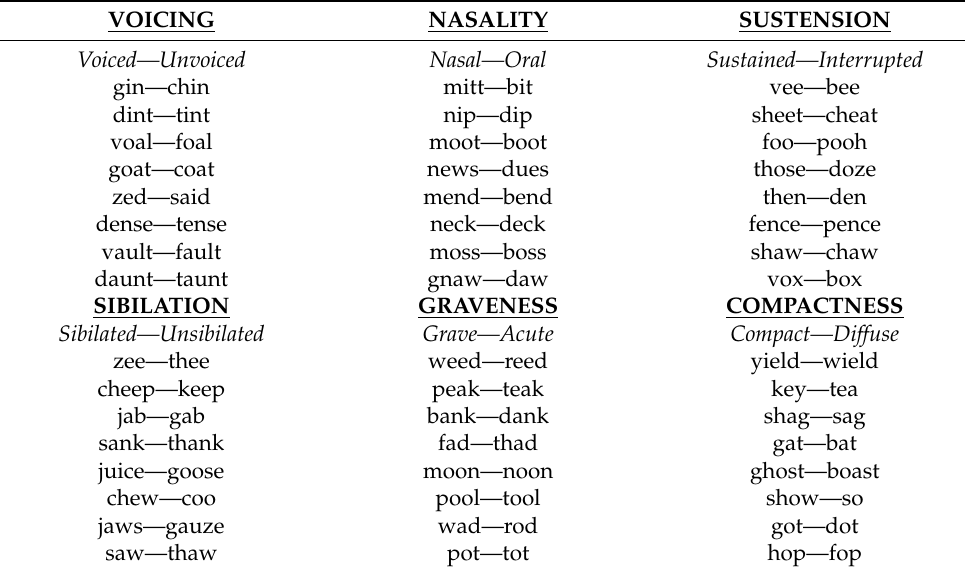
Table A2. Diagnostic Rhyme Test Word Pairs by Distinctive Feature Category a,b .